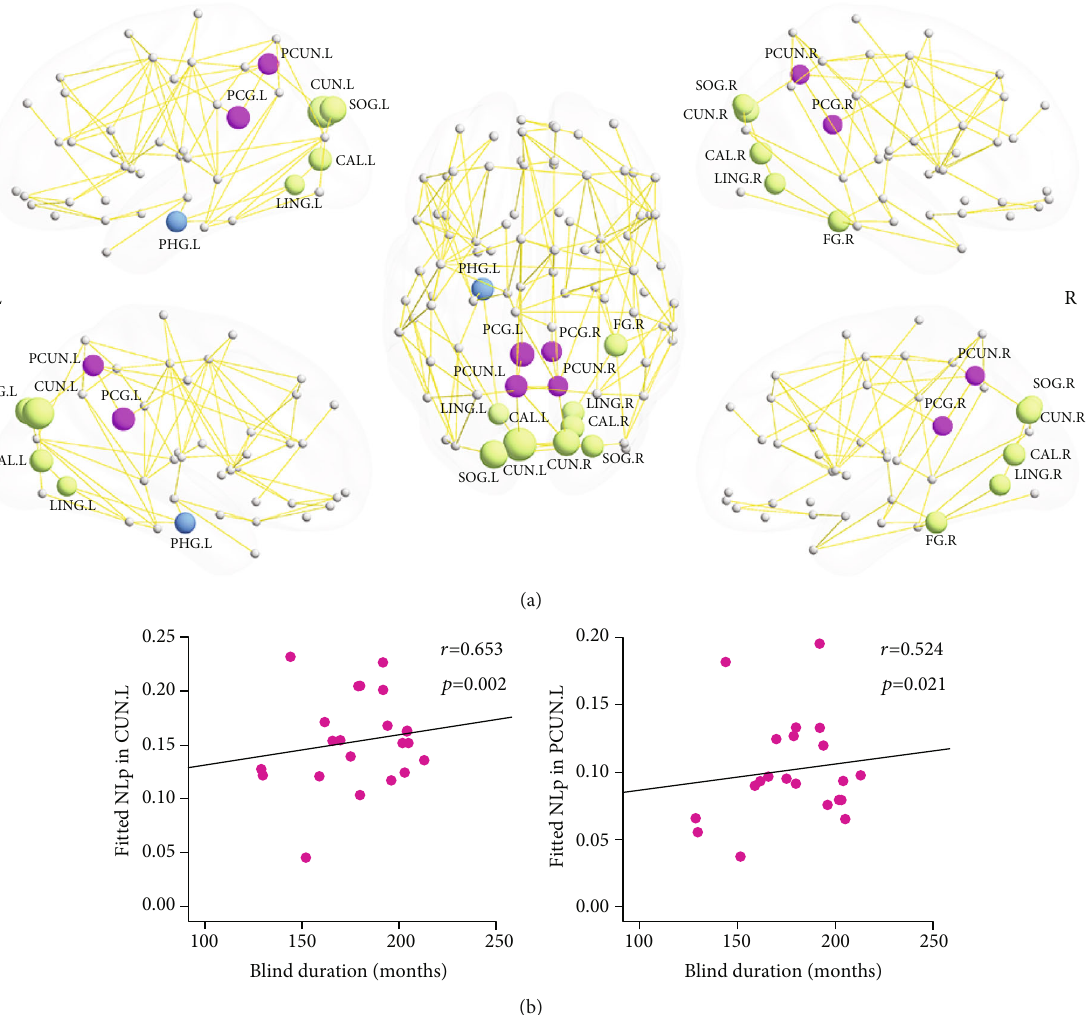
Figure 3: Distribution of brain regions with signi fi cantly intercohort di ff erences in nodal shortest path length (NLp) (a) and the correlation with blind duration in EBA cohort (b). (a) Regions with longer NLp are represented in di ff erent colors: purple for the default-mode system, green for the visual system, and blue for the limbic system. The node sizes indicate the signi fi cance of intercohort di ff erence in NLp. (b) Scatterplots show a signi fi cantly positive correlation between NLp and blind duration in EBA cohort ( n =21). The fi tted values indicate the residuals of original values of NLp adjusted age and sex and corrected with mean value. The abbreviations of nodes can be referred in Table